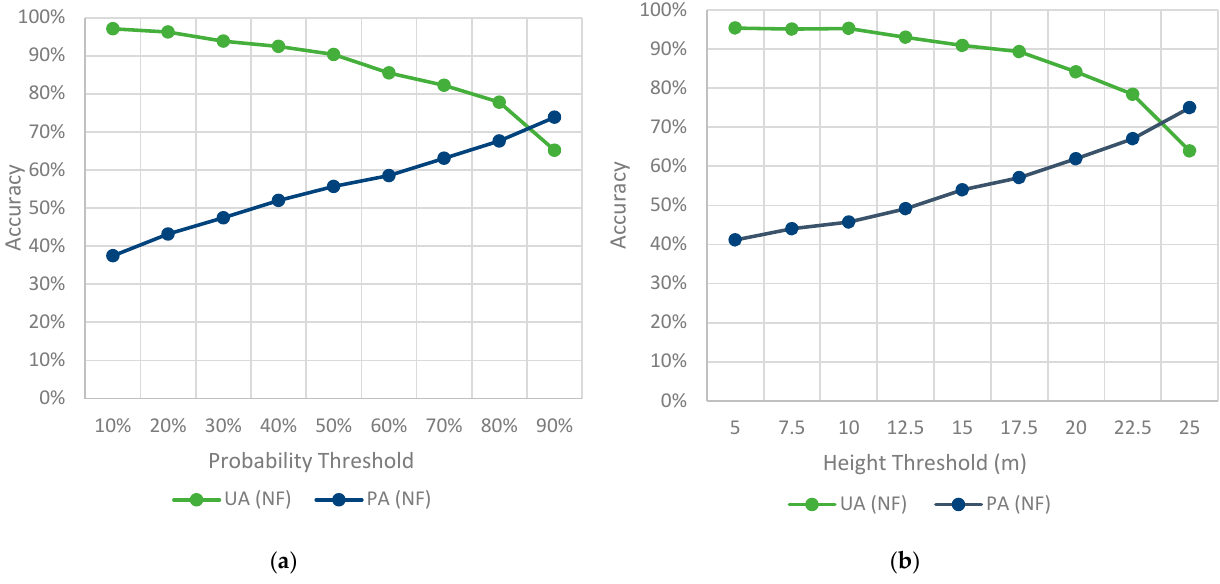
Figure 4. UA and PA of the non-forest (NF) class for the GEDI-FH/S1 model for increasing PT values ( a ) and for the GEDI-FH model for increasing height threshold values ( b ).